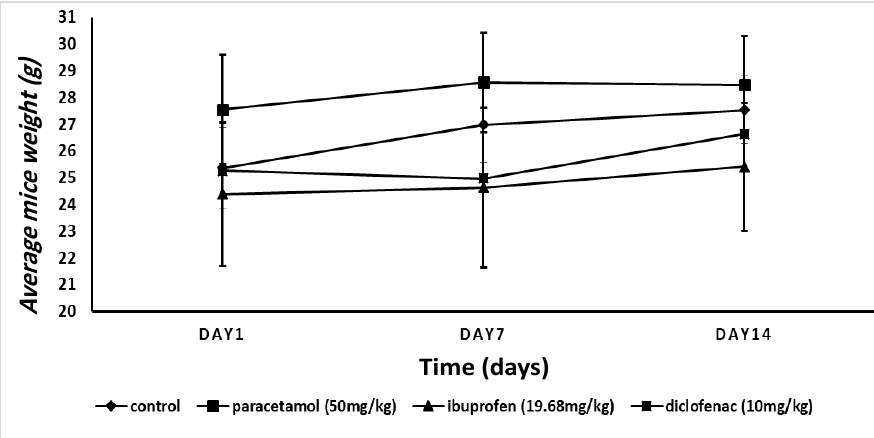
Figure 1. The changes in total body weight of the experimental mice. There was no significant change ( p > 0.05, two-way ANOVA) in the total body weight after 14 days of analgesic treatment.